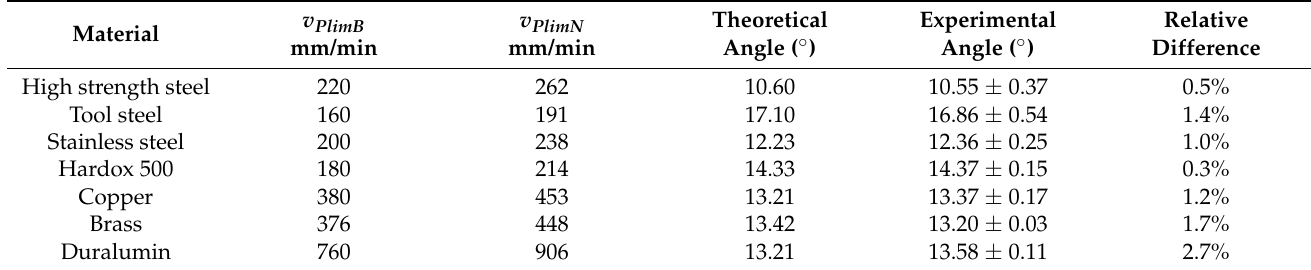
Table 5. Comparison of the theoretical calculations and the respective experimental data.